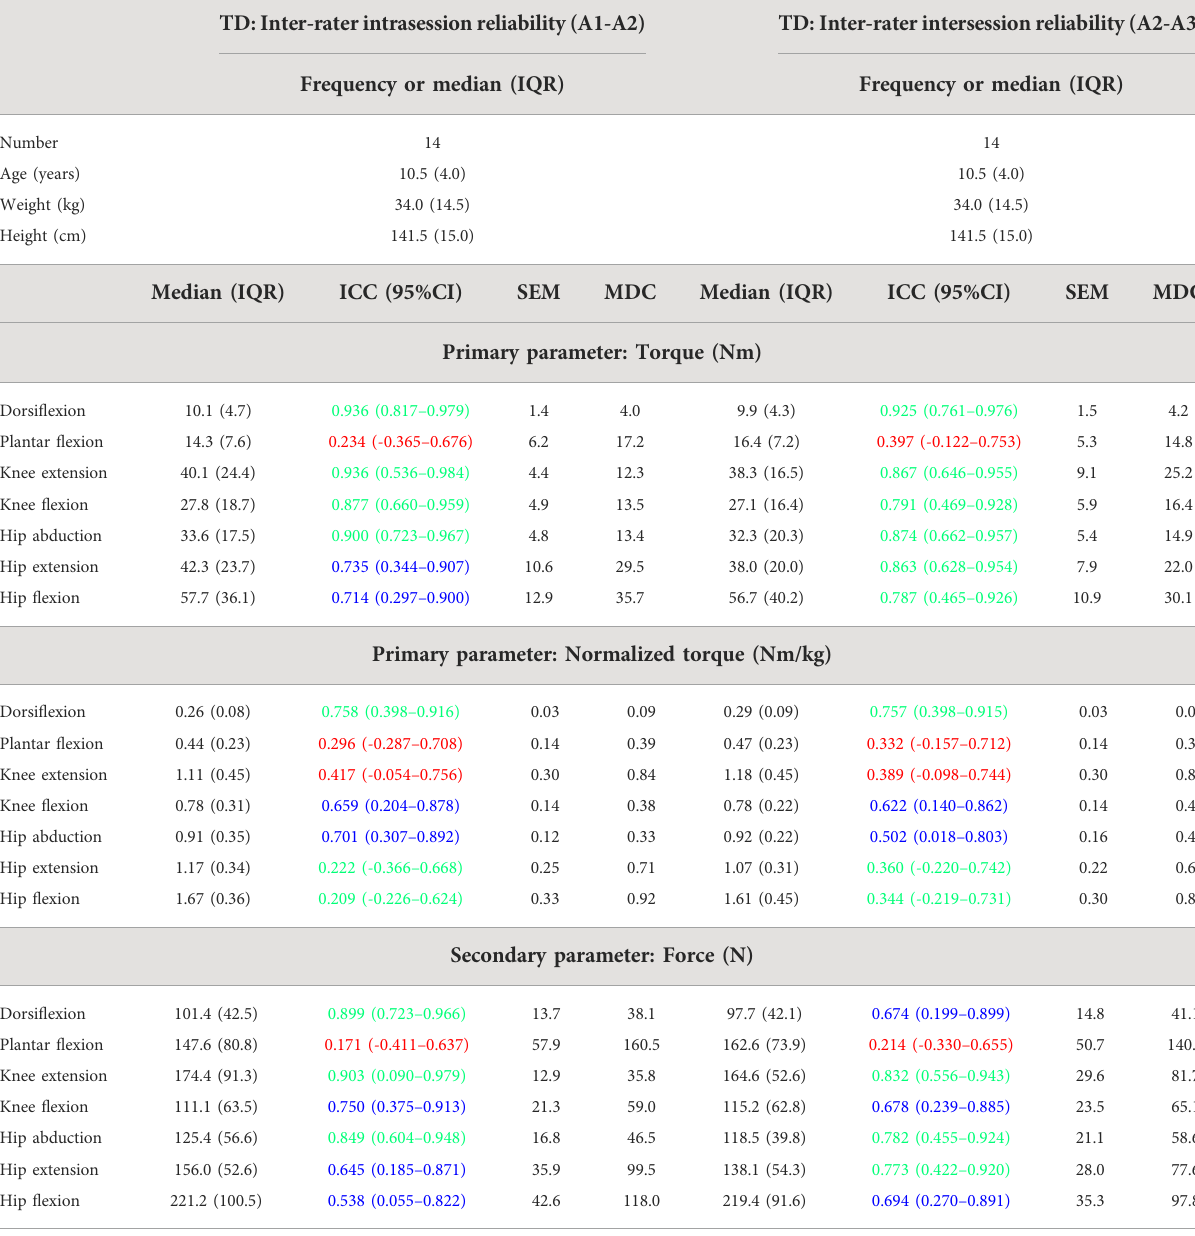
TABLE 3 Inter-rater intrasession and intersession reliability results for the TD children included in the reliability study. TD: Inter-rater intrasession reliability